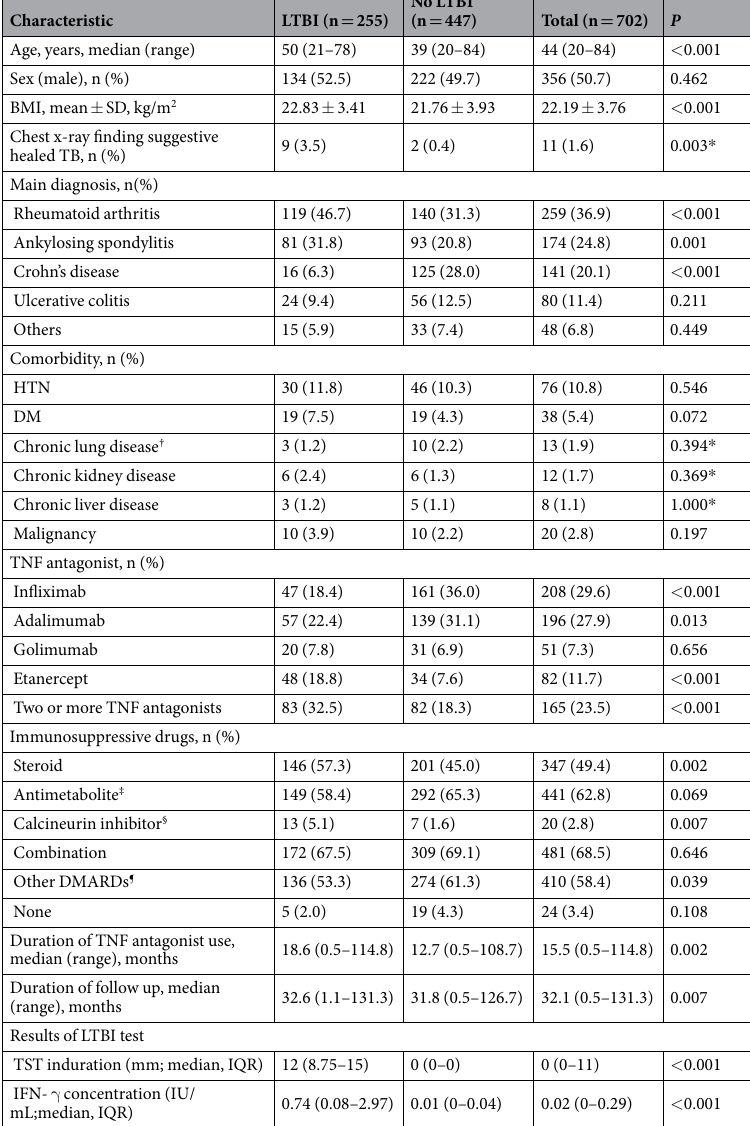
Table 1. Baseline characteristics of patients who were treated with TNF antagonists. Data are presented as numbers (percentages) unless otherwise indicated. * Compared using Fisher’s exact test. † Chronic obstructive pulmonary disease, asthma, bronchiectasis, interstitial lung disease. ‡ Methotrexate, Azathioprine. § Cyclosporine, Tacrolimus. ¶ 5-Amino salicylic acid derivative, Leflunomide. LTBI, latent tuberculosis infection; BMI, body mass index; TB, tuberculosis; HTN, hypertension; DM, diabetes mellitus; TNF, tumor necrosis factor; DMARD, disease modifying anti-rheumatic